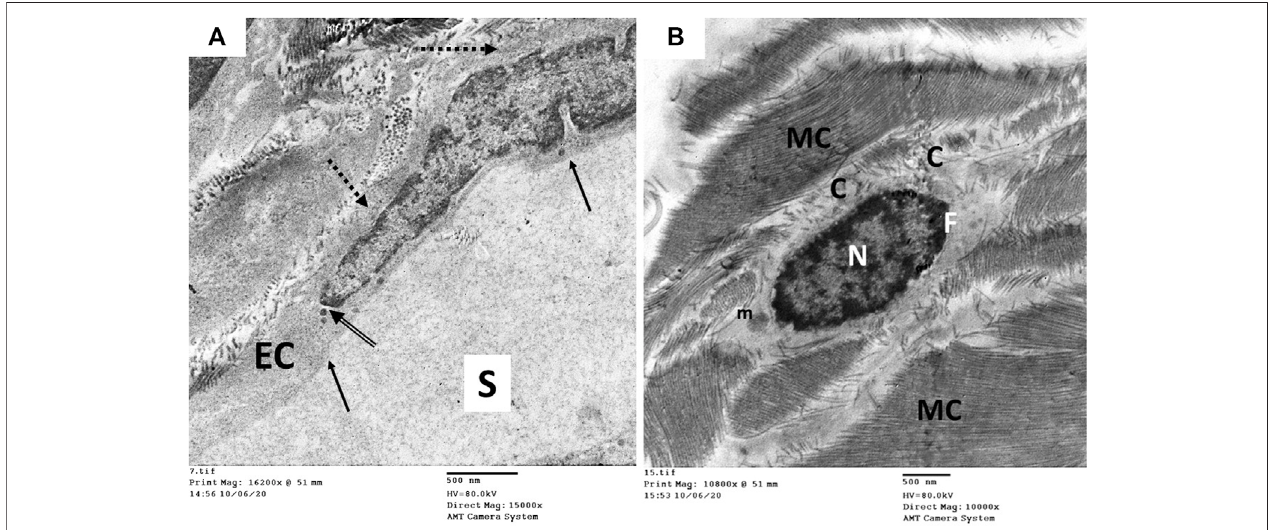
FIGURE13 | Transmission electron microscopic pictures ofthe CC ofdiabeticUSC-L-treated group (group IV) showing; (A) oneof the cavernous spaces (S) lined with endothelial cell (EC) with regular sooth luminal surface (arrow) and thin basal lamina (dashed arrow). Few pinocytic vesicles (double arrow) were found in its cytoplasm. (B) One fi broblast (F) with heterochromatic nucleus (N) and normal cytoplasmic organelles apart from few enlarged mitochondria (m). It exhibited no cytoplasmic processes but surrounded by many mature collagen fi bers (MC) and few immature ones (C).